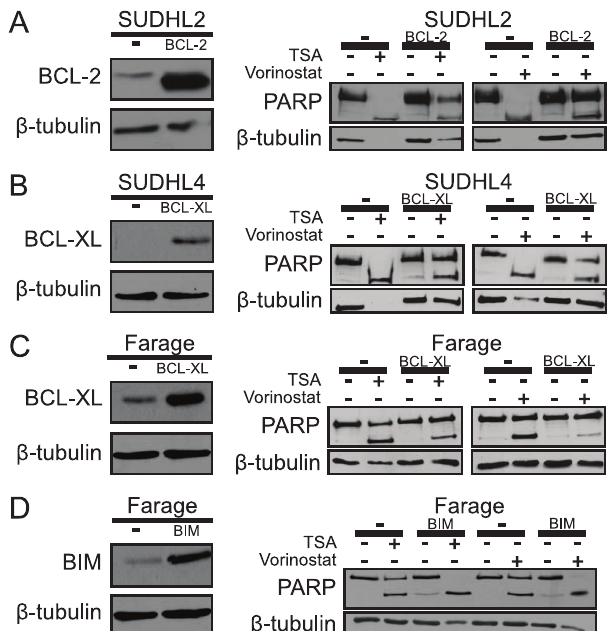
Figure 3. HDACi sensitivity is decreased by over-expression of BCL-2 or BCL-XL and increased by over-expression of BIM. Creation of four independent cell lines (SUDHL2 cells over-expressing BCL-2, SUDHL4 cells over-expressing BCL-XL, Farage cells over- expressing BCL-XL, and Farage cells over-expressing BIM) was confirmed by Western blotting for BCL-2, BCL-XL, and BIM ( A–D ) and compared to empty vector (–) transduced cells. b -tubulin was used as a normalizing control. ( A ) SUDHL2-BCL-2, ( B ) SUDHL4-BCL-XL, ( C ) Farage- BCL-XL, and ( D ) Farage-BIM cell lines were treated with either 300 nM TSA or 3 m M vorinostat for 24 h. Whole-cell extracts were made and Western blotting for PARP cleavage and b -tubulin (as a normalizing control) was performed. All cells over-expressing the protein of interest were compared to empty vector (–) transduced control cells.